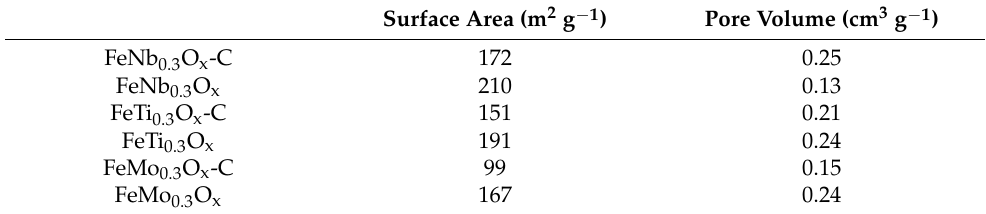
Table 2. Structural parameters of all the FeM 0.3 O x -C and FeM 0.3 O x (M = Nb, Ti, Mo)